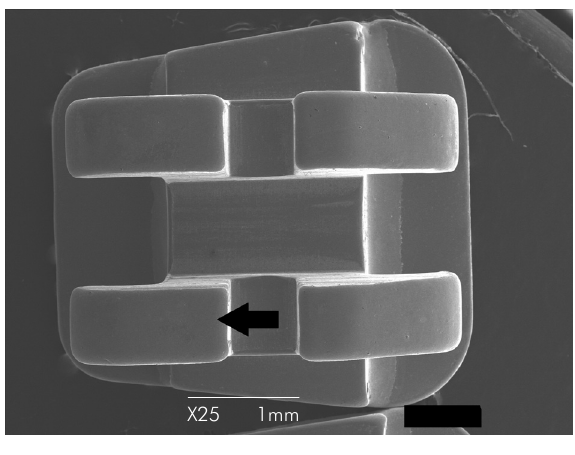
Figure 1. Frontal photomicrograph (general) at 25x magni- fication. Arrow pointing to the particular image generated at 500x magnification.